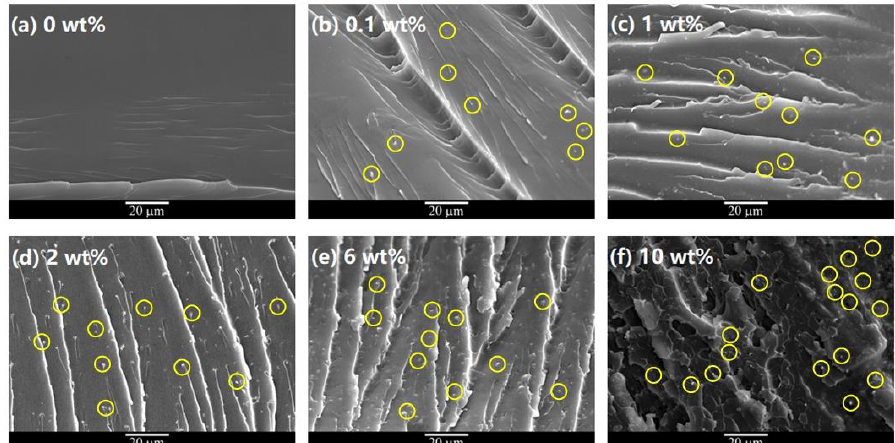
Figure 2. SEM pictures of the cross-sections of the samples with different additions of nano-MgO particles. ( a ) Neat epoxy, ( b ) 0.1 wt%, ( c ) 1 wt%, ( d ) 2 wt%, ( e ) 6 wt%, and ( f ) 10 wt%. The white dots marked by the yellow circles refer to the nano-MgO particles.